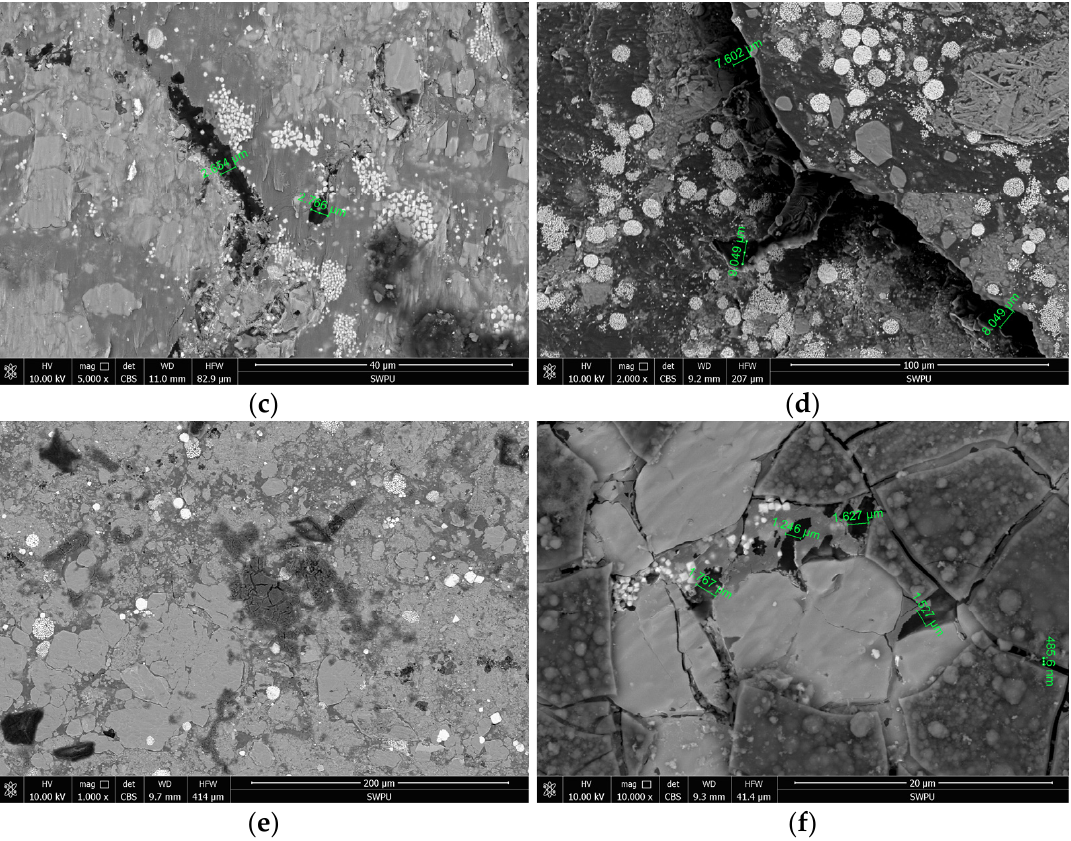
Figure 4. SEM experimental results of lamellar shales under 45 ° lamina occurrence: ( a ) Flat bedding fractures without soaking treatment; ( b ) nanoscale bedding fractures without soaking treatment; ( c ) surface debris spalling after soaking in water; ( d ) delamination occurs after soaking in water; ( e ) filling of debris surface by drilling fluid; ( f ) sealing of micro-scale fractures with drilling fluid materials.